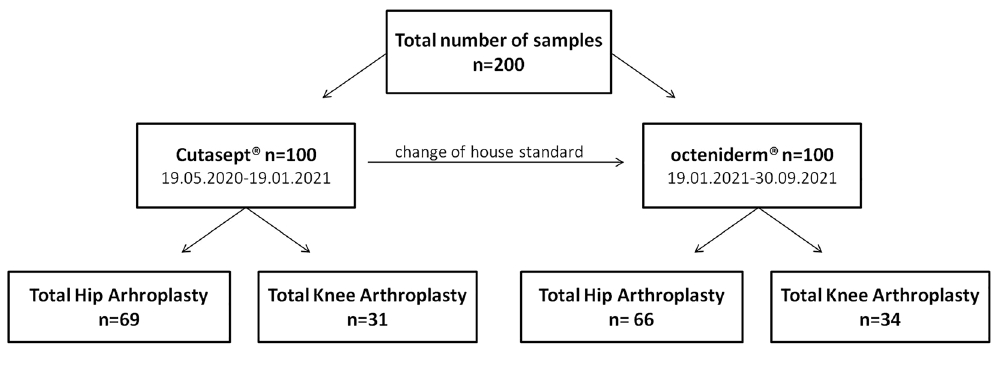
Figure 1. Flow chart of the skin